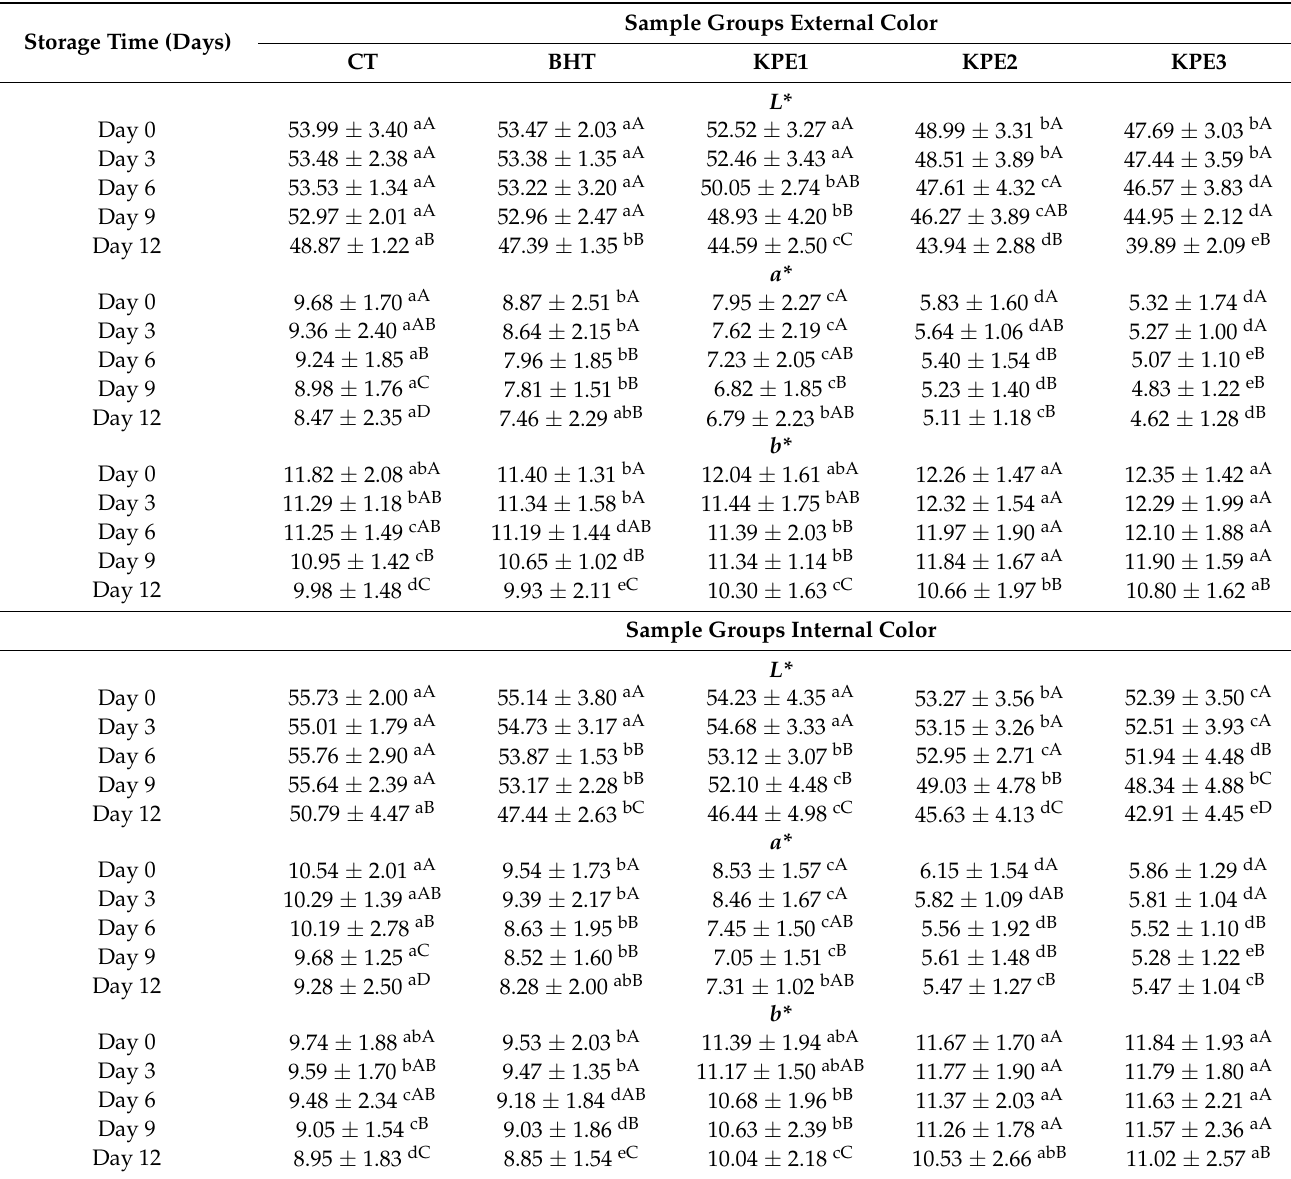
Table 2. Color of beef sausages during 12 d of refrigerated